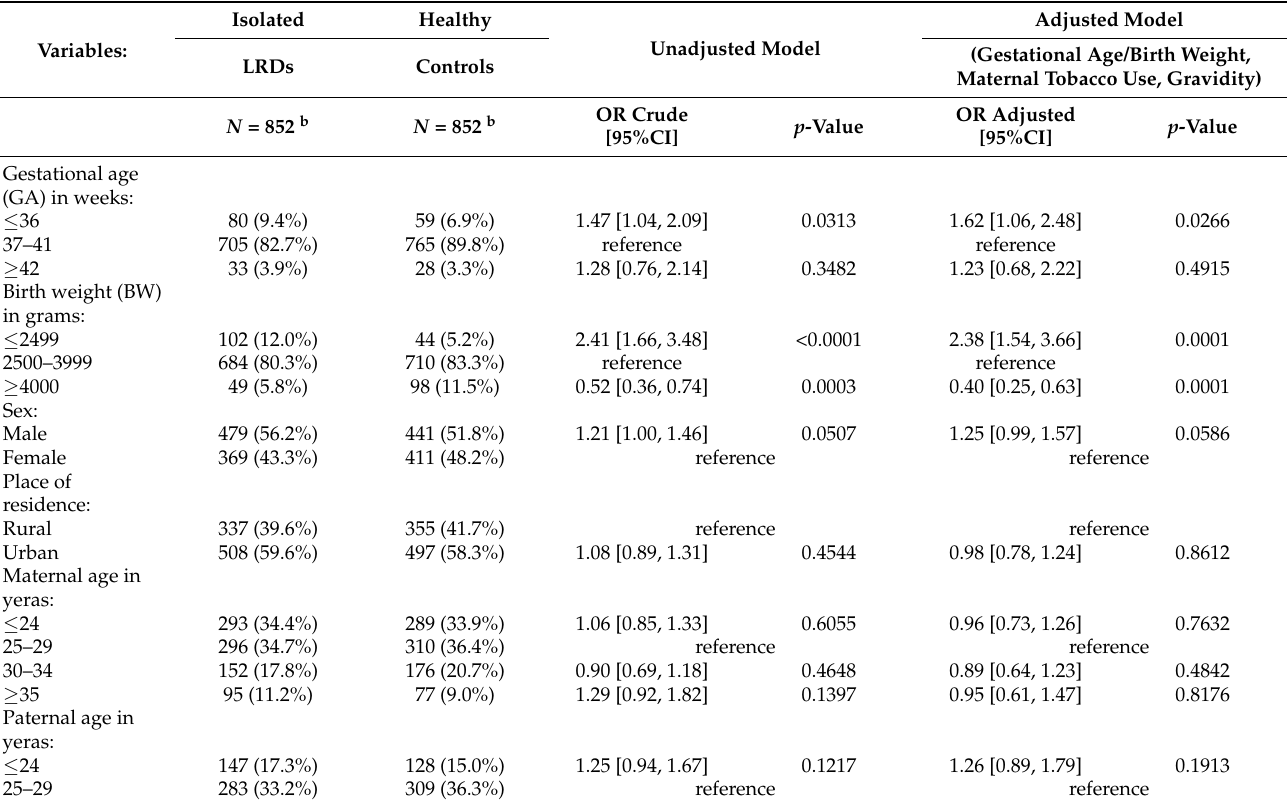
Table 2. The comparison of baseline characteristics between cases with isolated LRDs ( N = 852, PRCM 1998–2010) and population-matched healthy controls. The p -values and odds ratios (OR) were derived based on univariate (unadjusted) and multivariate (fully adjusted) logistic regression models, as described in the